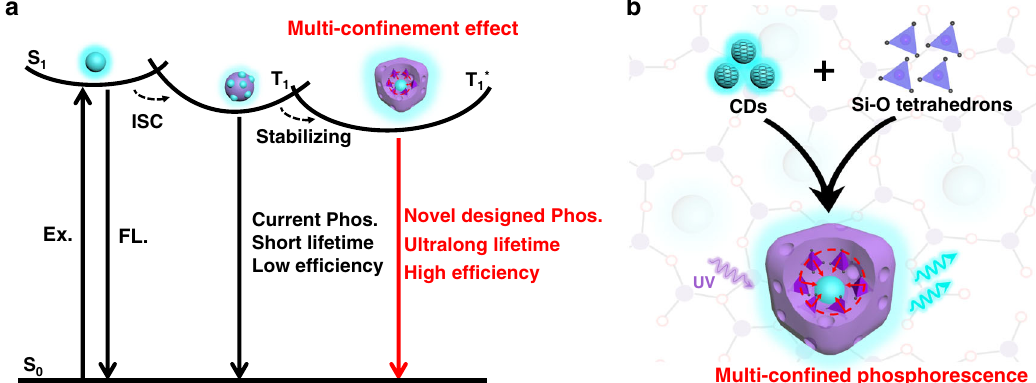
Fig. 1 Schematic of the proposed phosphorescence mechanism and design strategy of multi-con fi ned CDs@SiO 2 RTP material. a Proposed mechanism of CDs in conventional matrix and multi-con fi ned structure. (S0 ground state, S1 fi rst excited singlet state, T1 fi rst excited triplet state, ISC intersystem crossing, Ex. excitation, FL. fl uorescence, Phos. phosphorescence). b Schematic of the design strategy of the multi-con fi ned (rigid network, stable covalent bonds, and three-dimensional